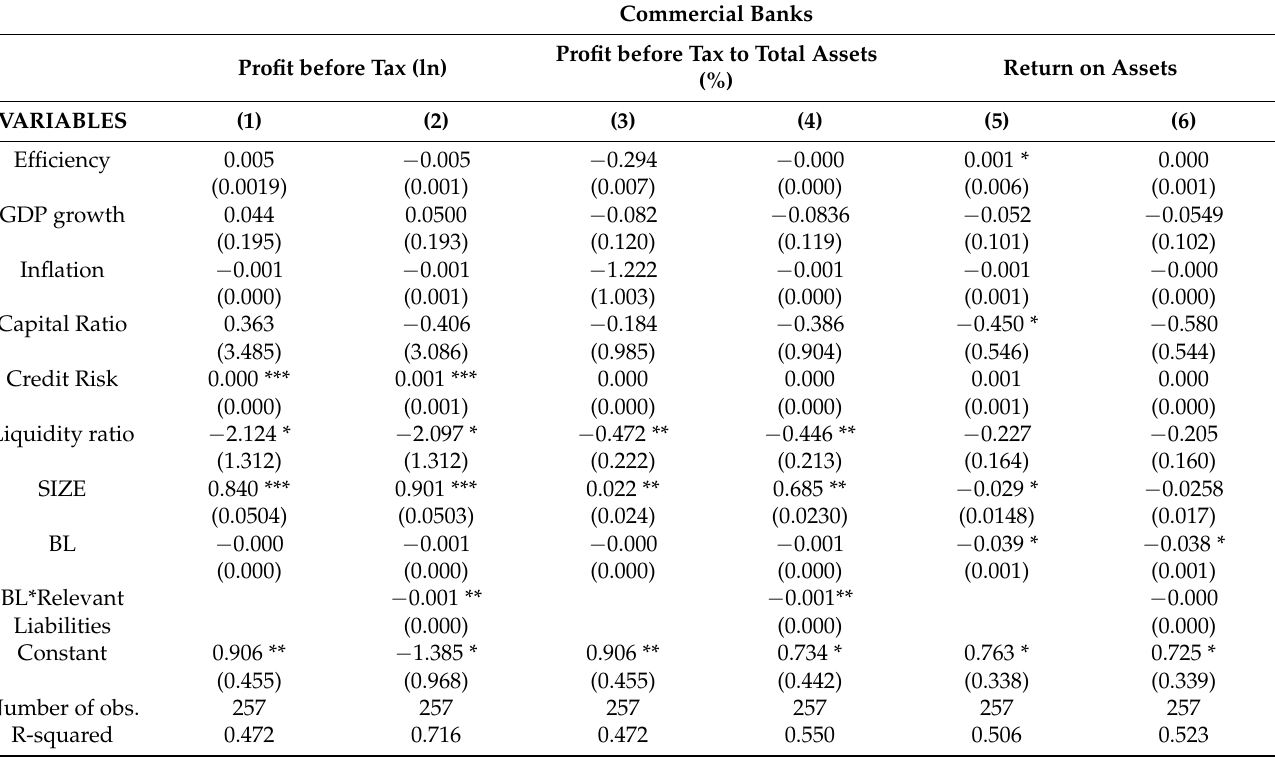
Table 6. Data presenting estimates based on GLS regressions with a random effect on German commercial banks. Symbols *, **, and *** represent statistical significance at the levels of 10%, 5%, and 1%,